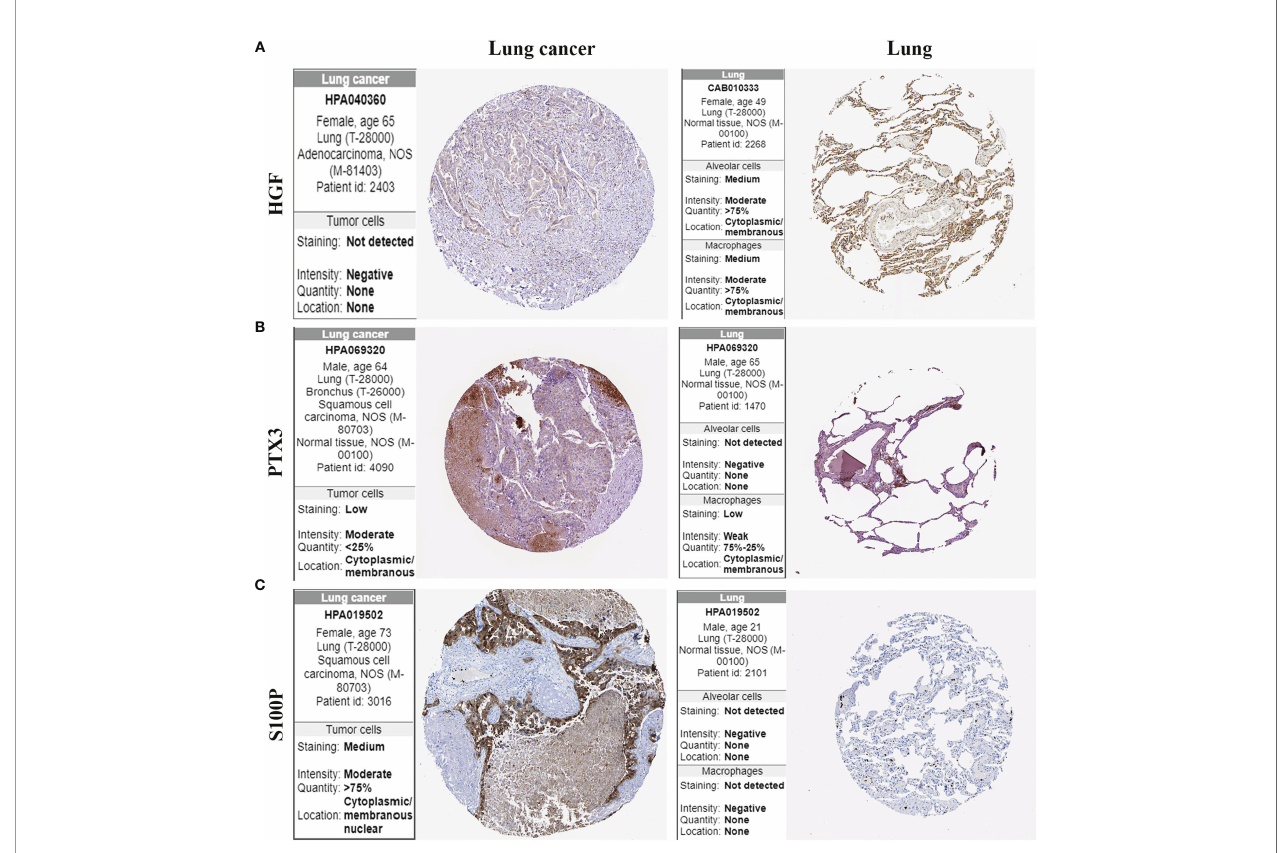
FIGURE 9 | Protein expression of HGF, PTX3, and S100P in lung cancer tissues and normal lung tissues. (A) HGF protein expression; (B) PTX3 protein expression; (C) S100P protein expression.